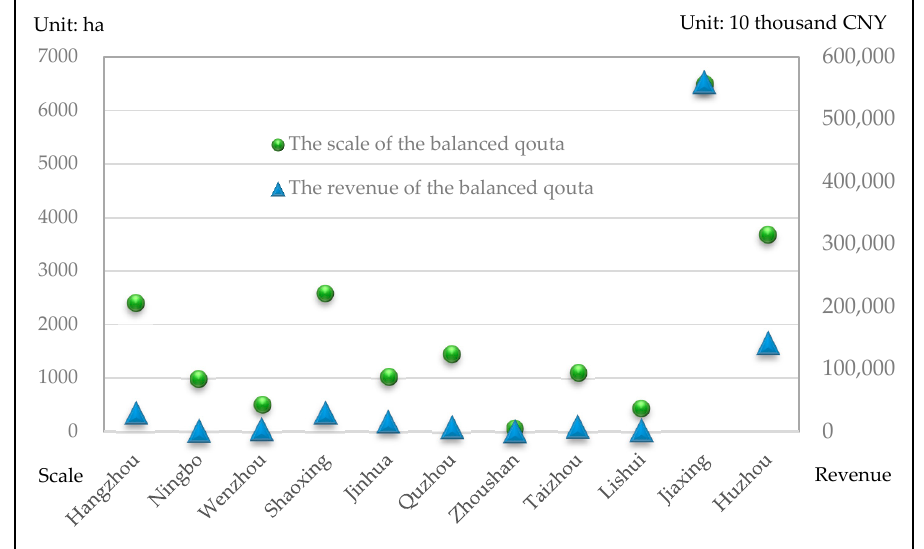
Figure 3. The comparing of the scale of the balanced quota with the benefits of 11 cities in Zhejiang province.